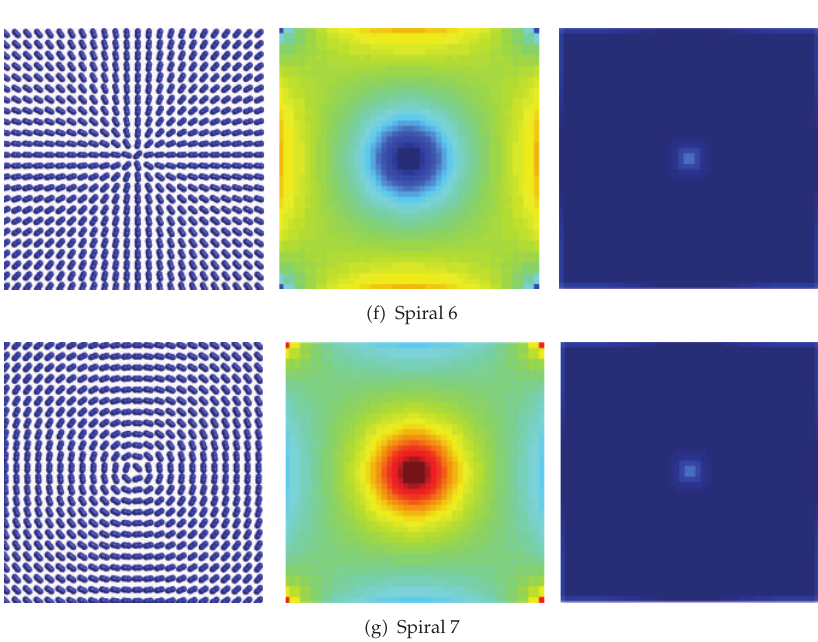
Figure 9: Spiral tensor field features with varying spiral angle (cid:3) left (cid:4) , the trace of the irrotational part of D (cid:3) middle (cid:4) , and the divergence of the irrotational part of D (cid:3) right (cid:4) .